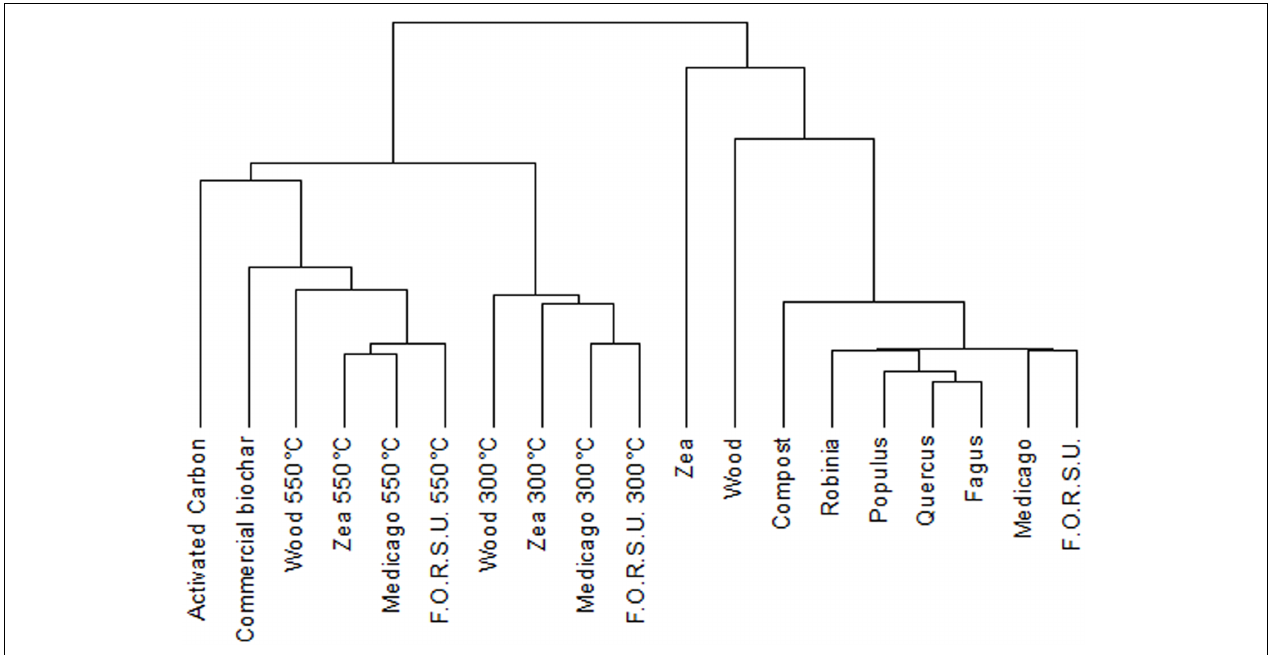
FIGURE 1 | Dendrogram from cluster analysis of the 19 organic materials (10 biochar and 9 not pyrogenic organic amendment).